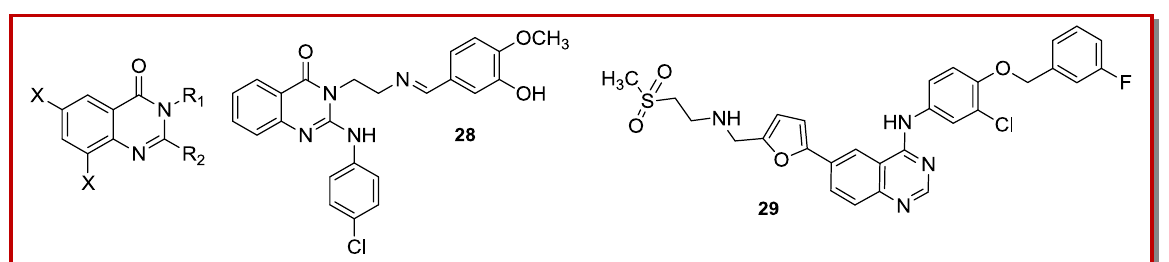
Figure 14: Selected bischalcones with cathepsin inhibitory activity